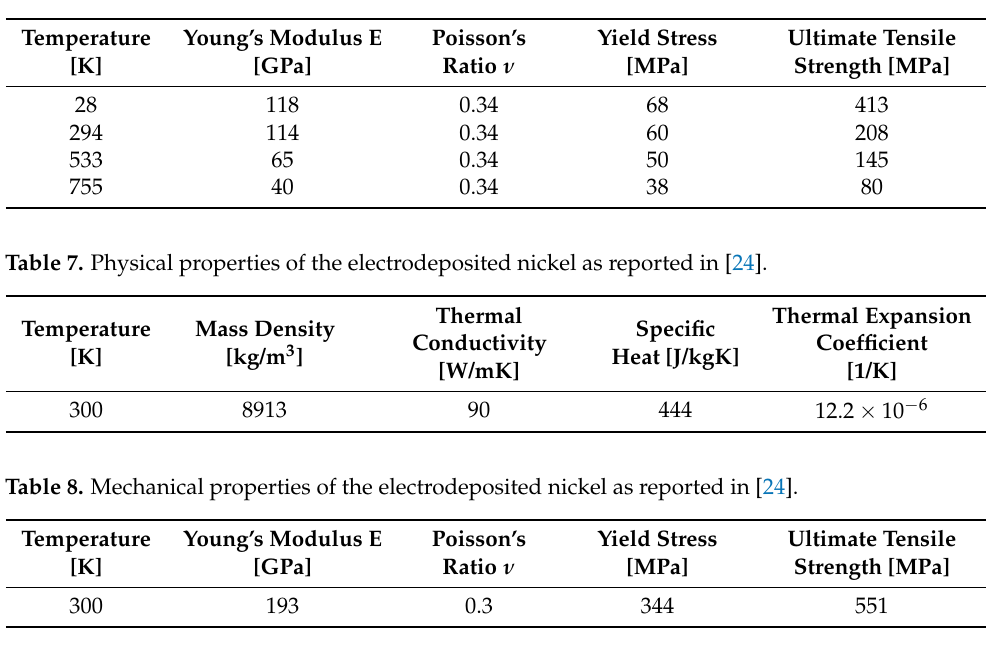
Table 6. Mechanical properties of the electrodeposited OFHC Cu [24].